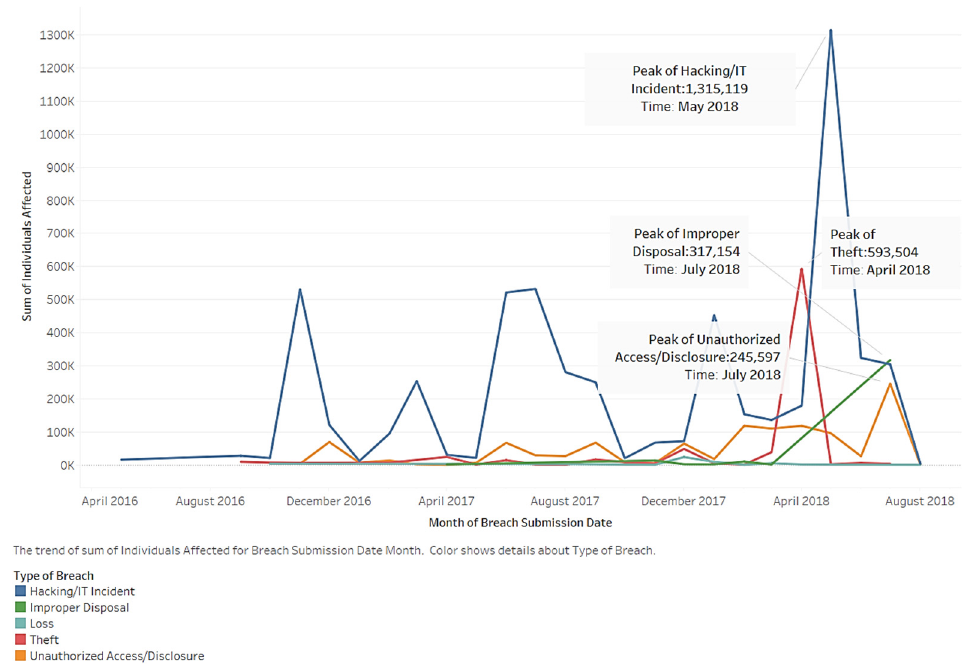
Figure 12. Trend of affected individuals by breach and breach type.